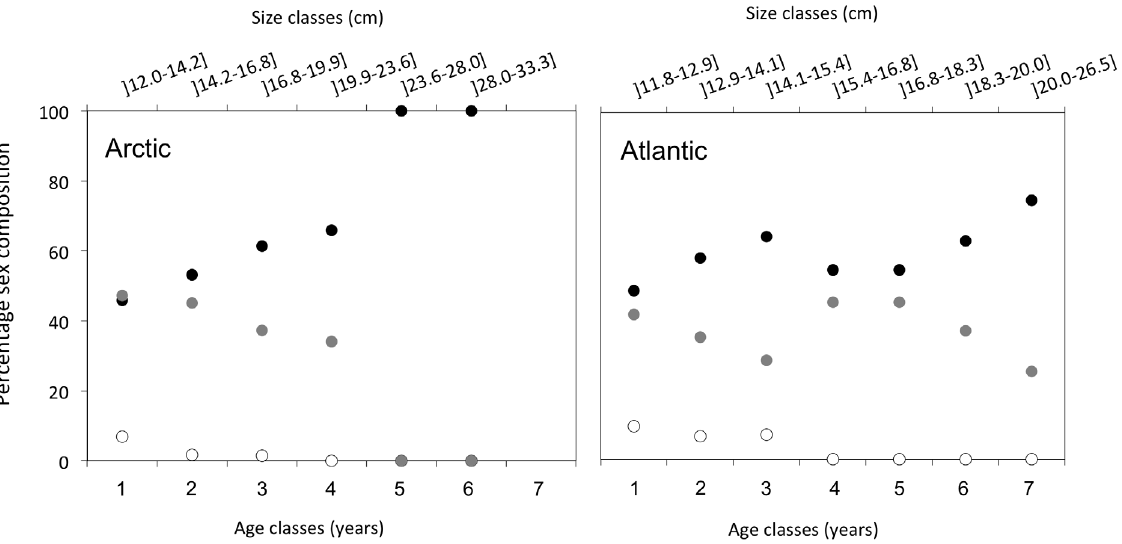
Figure 3. Sex ratio composition of polar cod in Arctic and Atlantic domains. Percentage female (black circles), male (grey circles) and immature (open circles) per age class of polar cod (lower x-axis) and size classes (cm, upper x-axis) from the Arctic (n=1813) and Atlantic (n=728) domains. Immature are individuals where gonads were not detectable. Age classes are derived from the linear regression presented in Figure 4, hence length ranges per age class differ for the two domains. Within the Arctic domain, a total of 74 females (max length 30.5 cm) and 30 males (max length 22.9 cm) were recorded larger than 20 cm. In the Atlantic domain only 53 females (max 26.5 cm) and 18 males (max length 25.0 cm) were recorded larger than 20 cm. For more details see Table S4.